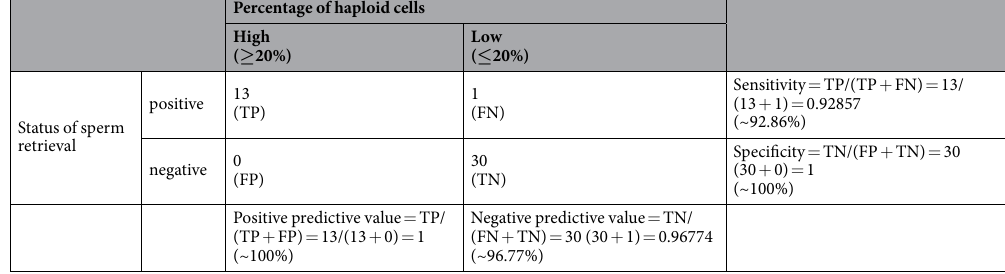
Table 2. Specificity and Sensitivity of the flow cytometric test. Note: TP: true positive, FN: false negative, FP: false positive, TN: true